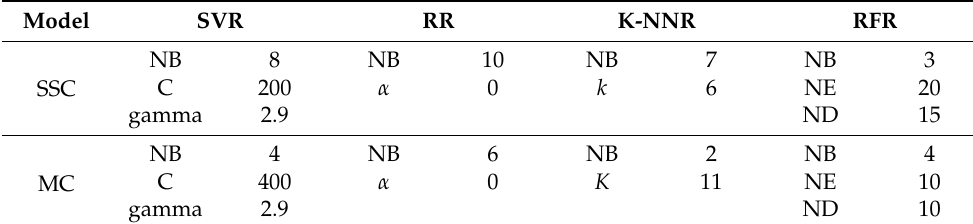
Table 3. The optimal parameters for each prediction model.